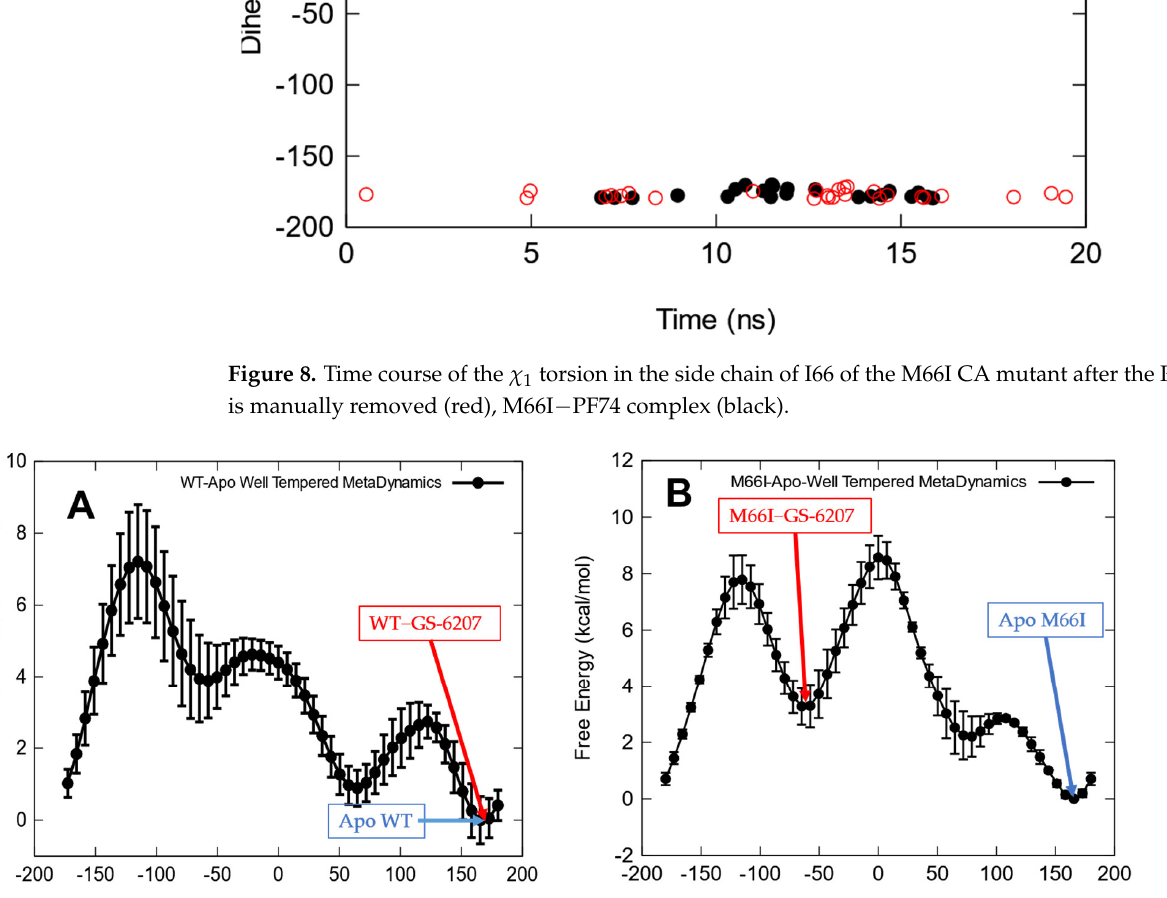
Figure 9. Free energy profiles along the χ 1 dihedral angle of the side chain of residue 66 in ( A ) apo wild-type CA and ( B ) apo M66I mutant.